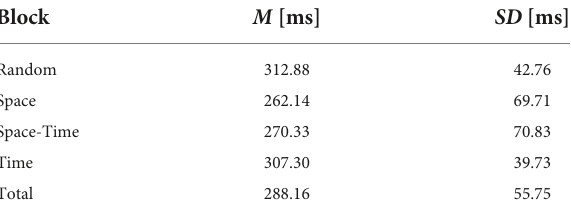
TABLE 2 Descriptive statistics for the behavioral results (reaction times in the testing phase, mini-blocks